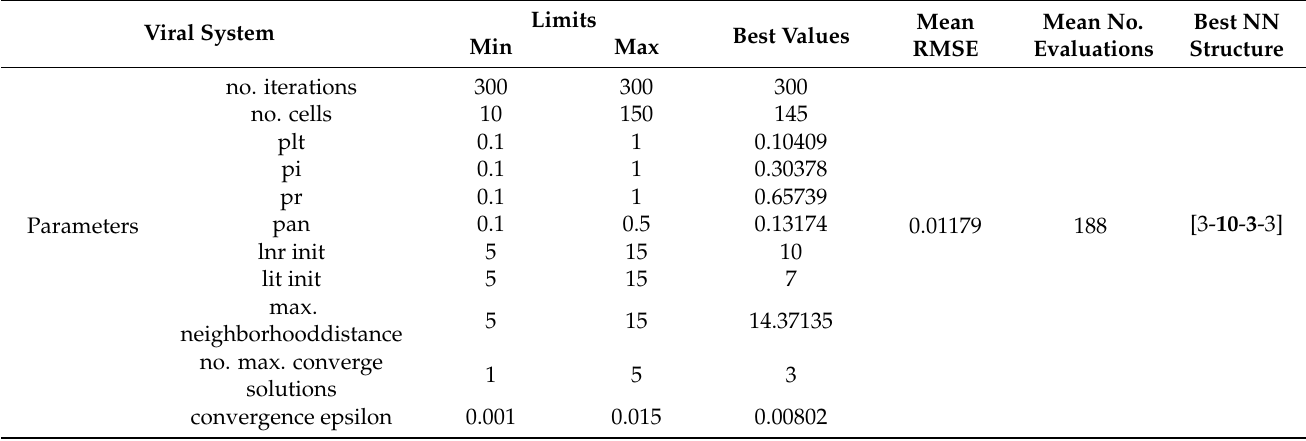
Table A6. The best results provided by the search procedure for the Viral System algorithm.